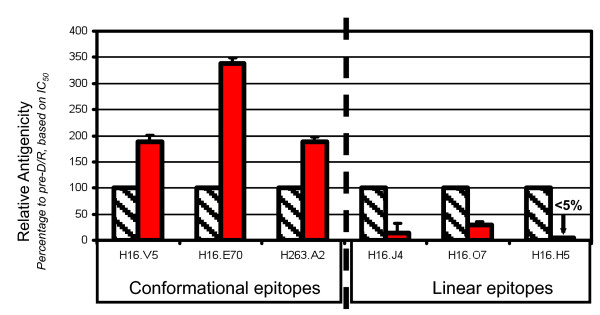
Quantitative assessment of the impact of D/R on the reactivities of different antibodies to HPV16 VLPs by ELISA. Bar graph of relative IC50 values (after normalizing to the pre-D/R control, based on the data in Table 2) for a panel of mAbs against post-D/R VLPs (solid bars) as compared to pre-D/R VLPs (hashed bars). A larger value indicates higher antigenicity based on the half-maximal binding titers-initially derived in ng/mL for L1 concentration in VLP preparations.